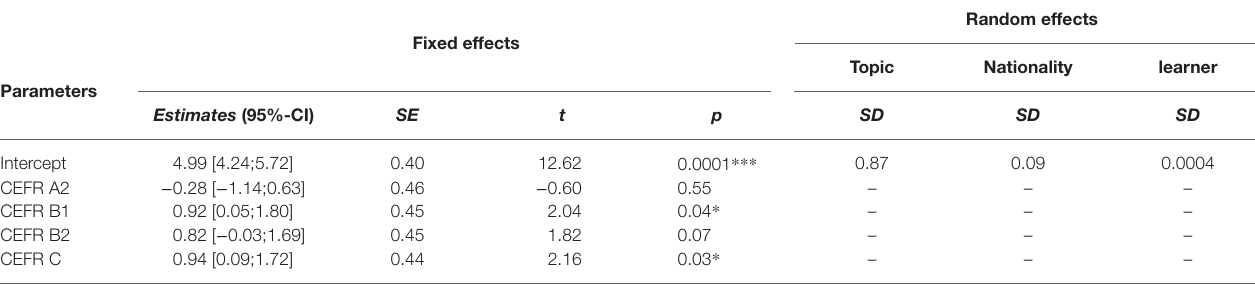
TABLE 6 | Summary of the mixed effects model for the length of noun elements.